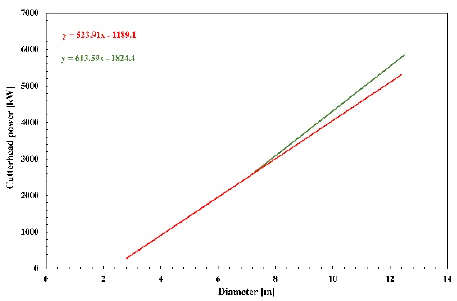
Figure 24. Trend of the thrust vs. the diameter based on data collected from the analysis of single shield TBMs. In red, the experimental model proposed in this study; in blue, the model proposed by [42].